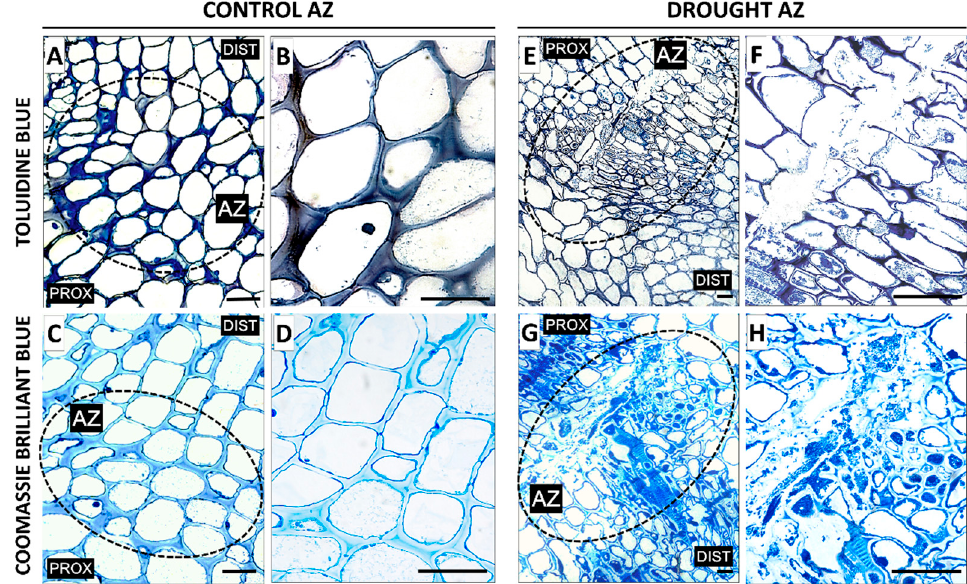
Figure 2. The impact of soil drought stress (25% WHC) on the structural features in the flower abscission zone (AZ) of Lupinus luteus . For observations, sections of AZ were excised on the 48th day of cultivation. Samples of AZ from control and drought-stressed plants were stained with toluidine blue ( A , B , E , F ) or Coomassie Brilliant Blue ( C , D , G , H ). Images B, D, F, and H are magnifications of different areas presented in A, C, E, G, respectively. AZ area was marked by black dotted circle ( A , C , E , G ). Abbreviations: PROX—stem fragments below the AZ, DIST—flower pedicel fragments above the AZ. Scale bars: 40 µm.